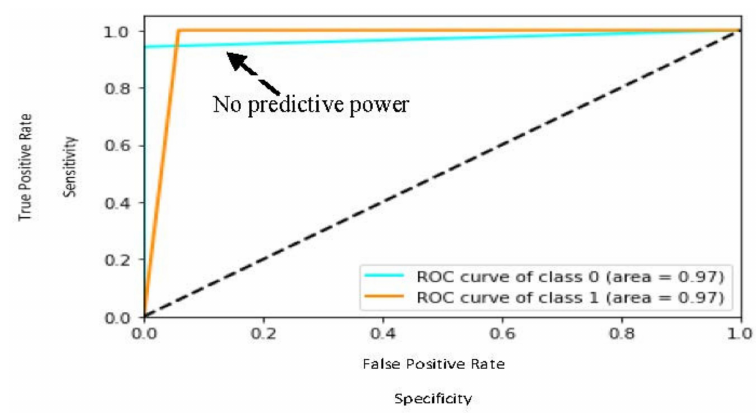
Figure 7. ROC result for SentiChurn